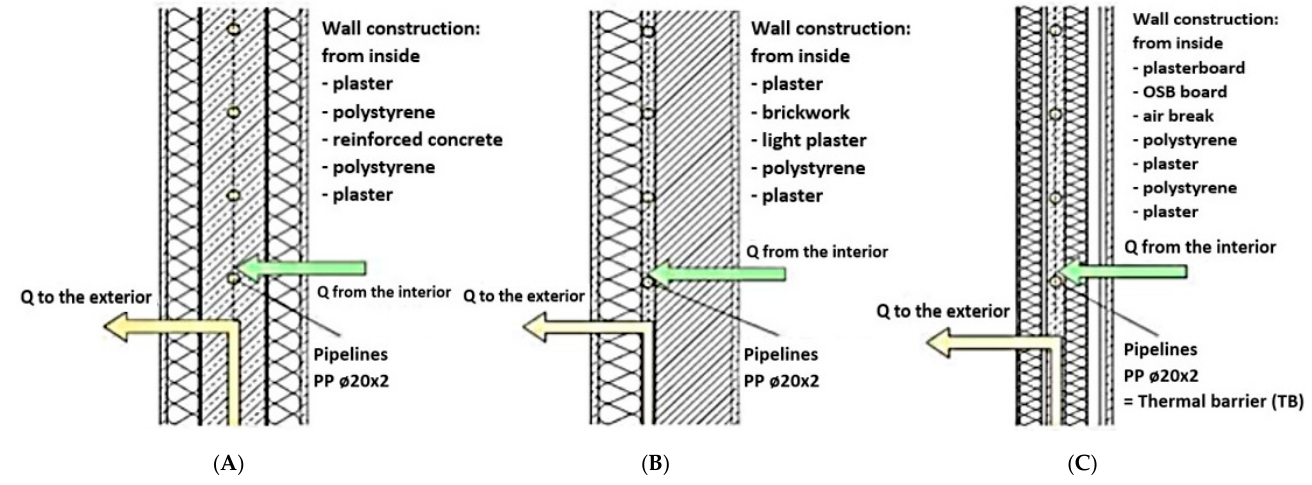
Figure 5. Schematic representation of thermal barrier walls [1,2]. ( A )—Reinforced concrete wall insulated on both sides; ( B )—Masonry wall; ( C )—Timber house wall. The patented ISOMAX system uses pipe-in-pipe heat recovery ventilation that is both outside and beneath the building for building ventilation, as shown in Figure 6 [1,2]. The ISOMAX control system is designed individually for each building (Figure 7) [1,2].